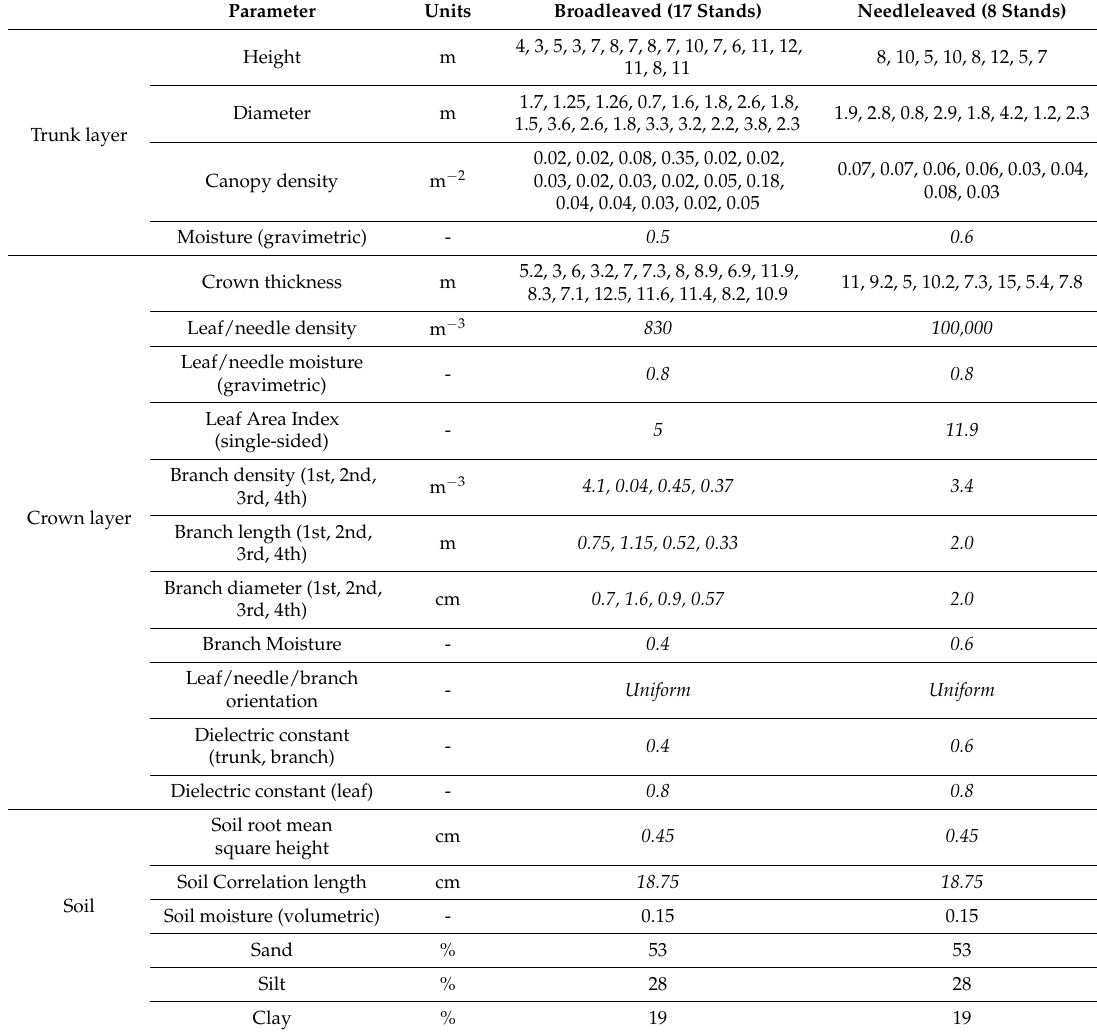
Table 3. Input parameters for MIMICS-I model: normal = measured; italics =